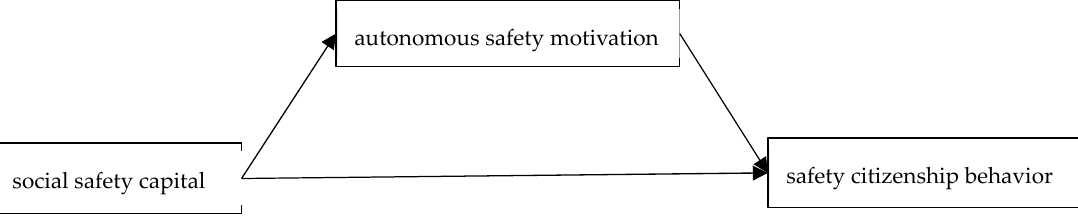
Figure 1. Framework of the mediated model proposed and tested in this study.